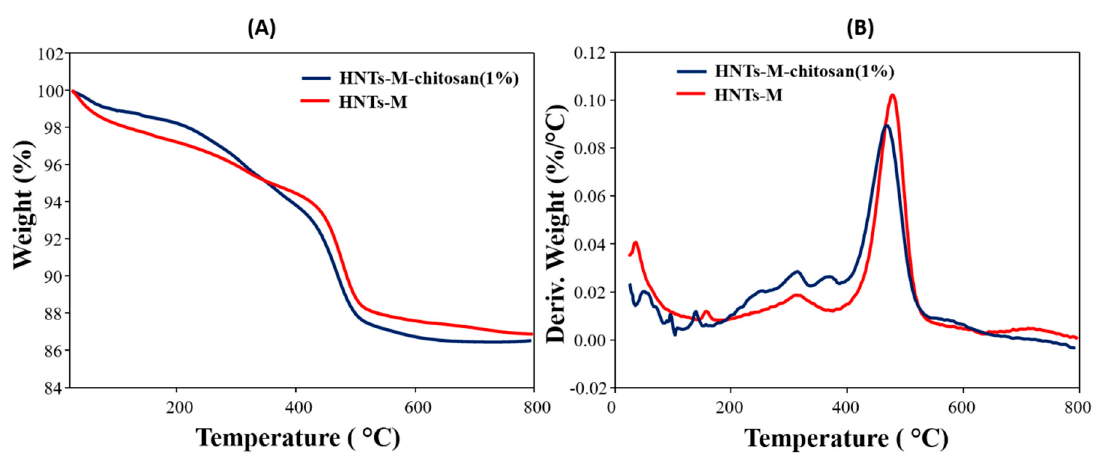
Figure 5. TGA ( A ) and derivative thermogravimetry (DTG); ( B ) analysis of HNTs-M and HNTs-M- chitosan (1%).